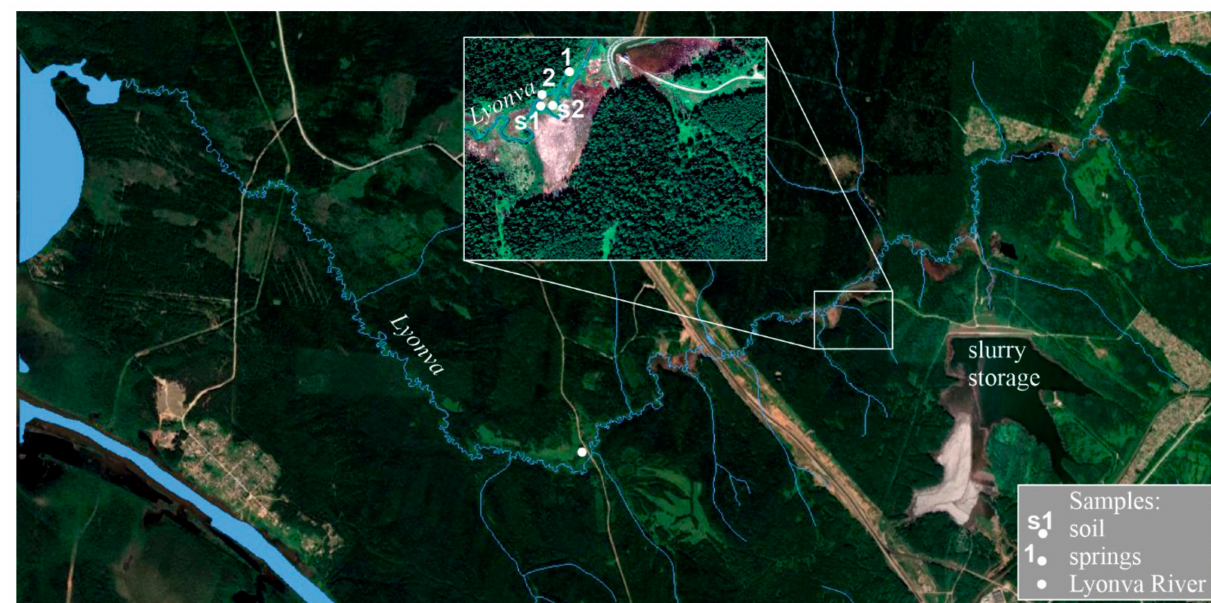
Figure 4. Locations of water and soil sampling sites.